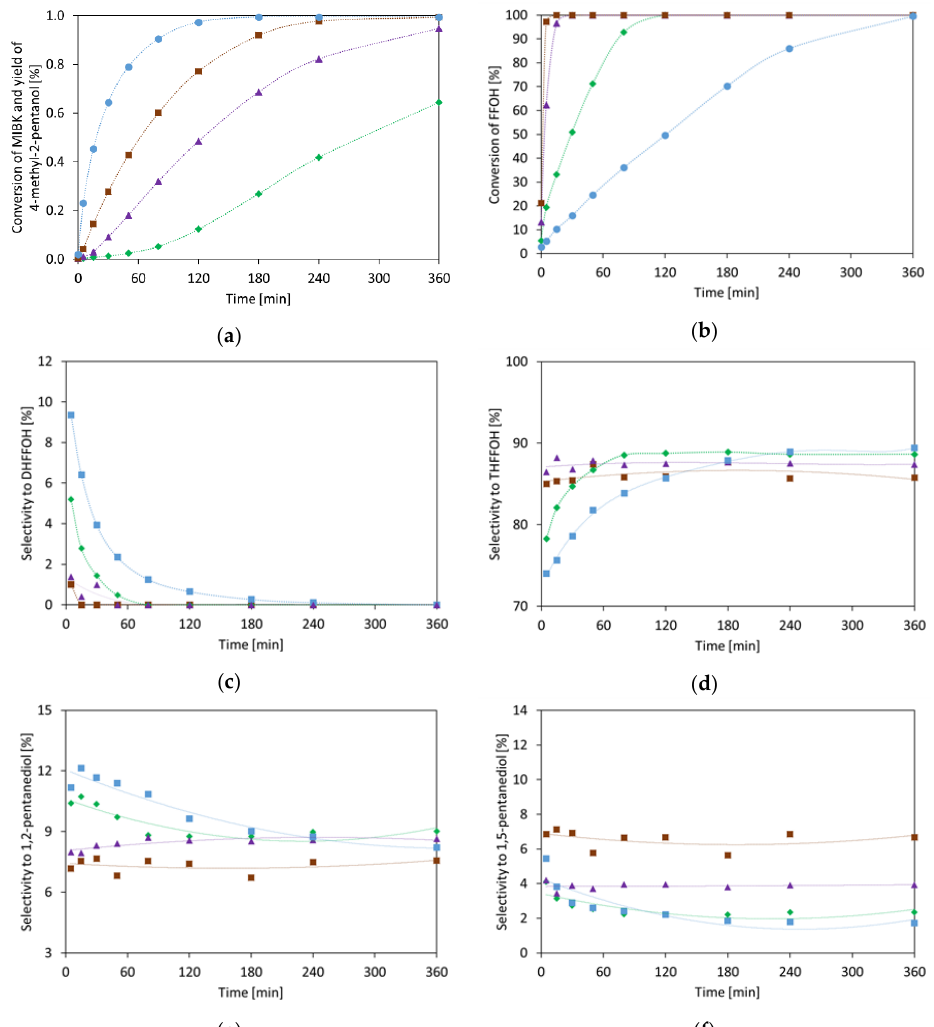
Figure 7. ( a ) Conversion of methyl isobutyl ketone (MIBK) and yield of 4-methyl-2-pentanol; ( b ) Conversion of FFOH. Selectivity to ( c ) DHFFOH, ( d ) THFFOH, ( e ) 1,2-pentanediol, and ( f ) 1,5-pentanediol at 70 °C in MIBK:furfuryl alcohol mixtures of 100:0, 90:10, 80:20, 50:50, and 0:100 mol:mol.